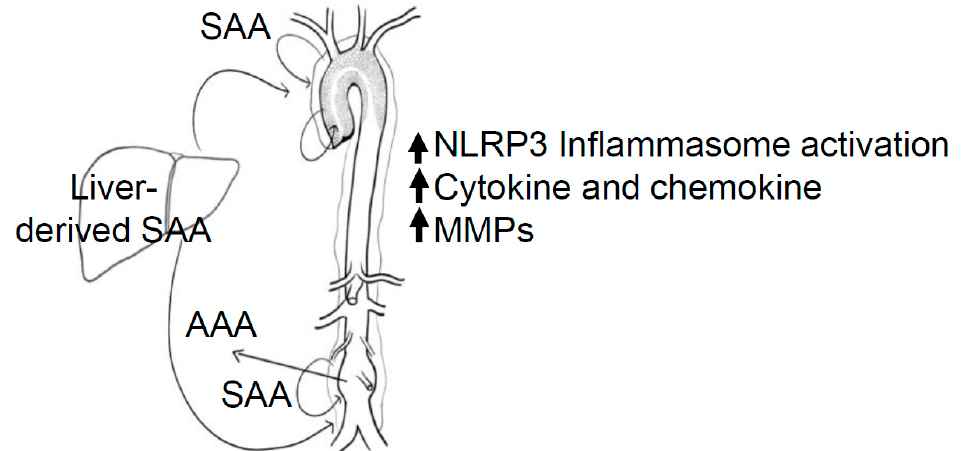
Figure 3. Three possible non-exclusive pathways, whereby SAA impacts the development of atherosclerosis/AAA formation. SAA secreted by the liver, peri-aortic adipose tissues, and/or aorta possibly act in an endocrine, paracrine, or autocrine way respectively by NLRP3 inflammasome activation [55,93–95,99] and cytokine, chemokine, and/or MMP expression [32,71,107–109], exacerbating the development of atherosclerosis/AAA.